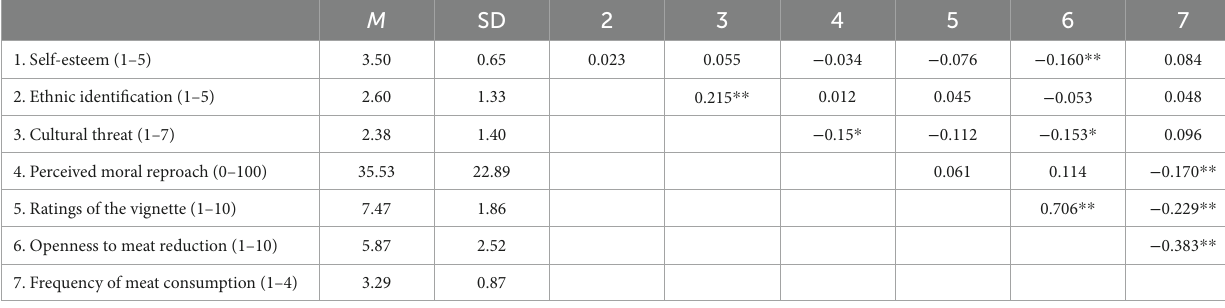
TABLE 1 Descriptive statistics and correlations of the measured variables ( N =